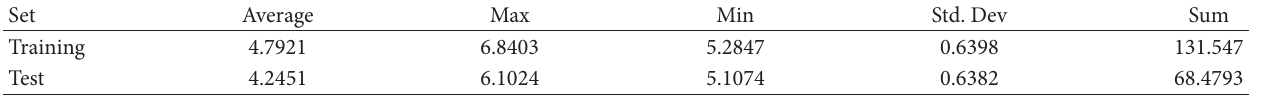
T 2: Unicolumn statistics of training and test set for QSAR